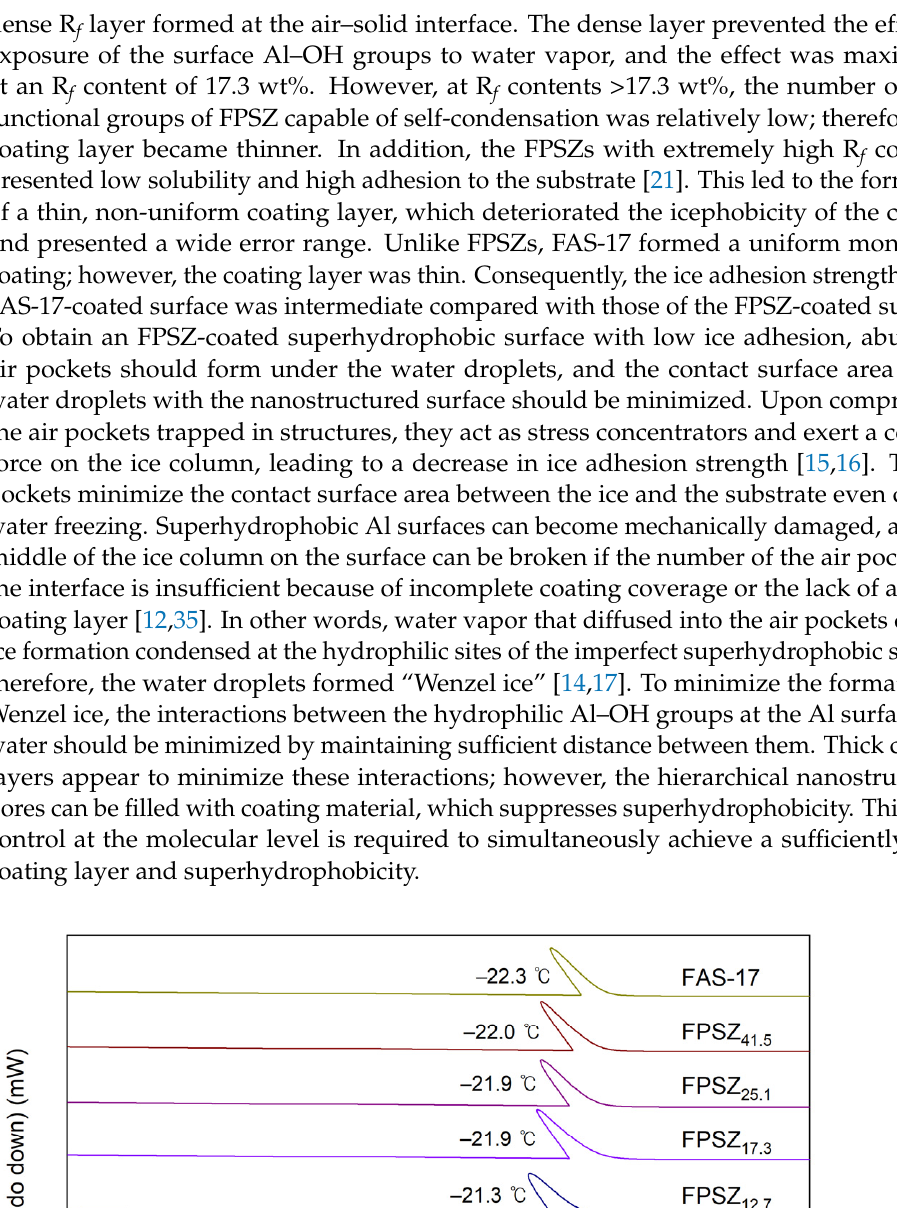
Figure 6. Optical images of 10 μ L water droplets on coated Al surfaces.